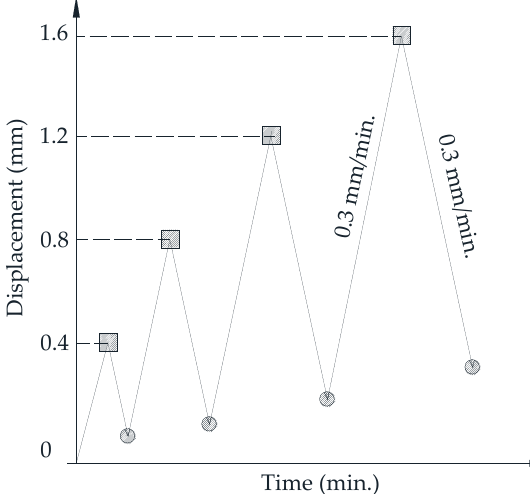
Figure 5. Load scheme of cyclic compressive test.